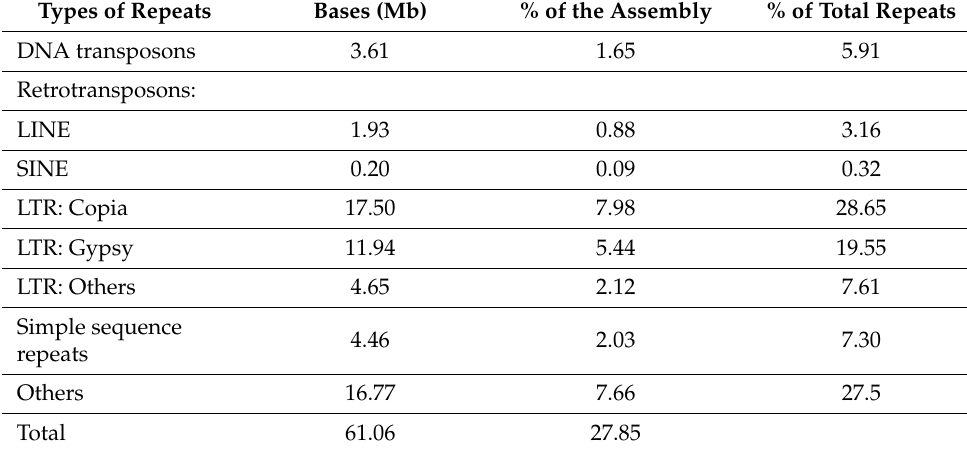
Table 3. Repeat contents in the R. mucronata genome